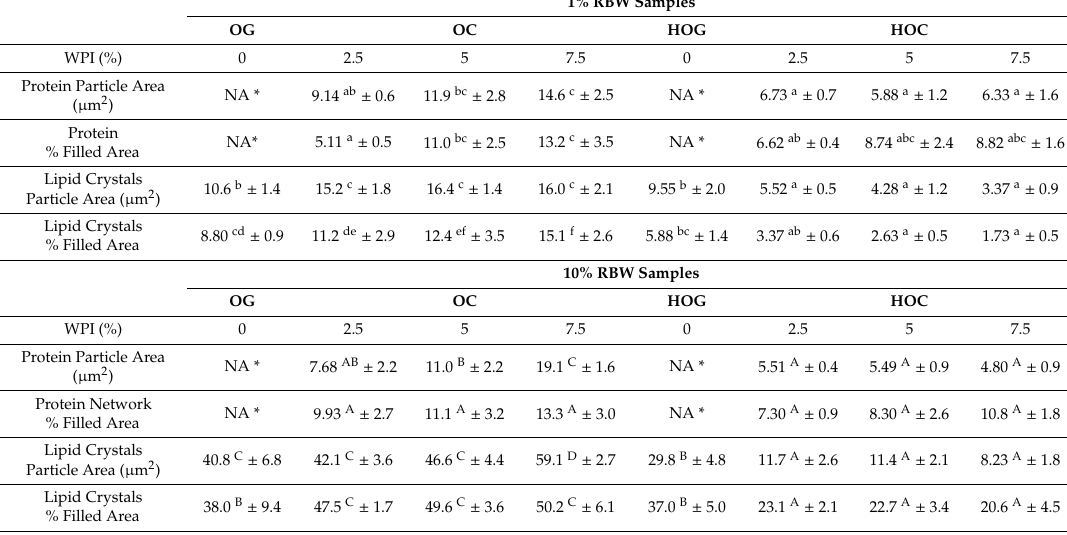
Table 5. Particle area and percent filled area of protein and lipid crystal networks within the colloidal networks, obtained from confocal and PLM